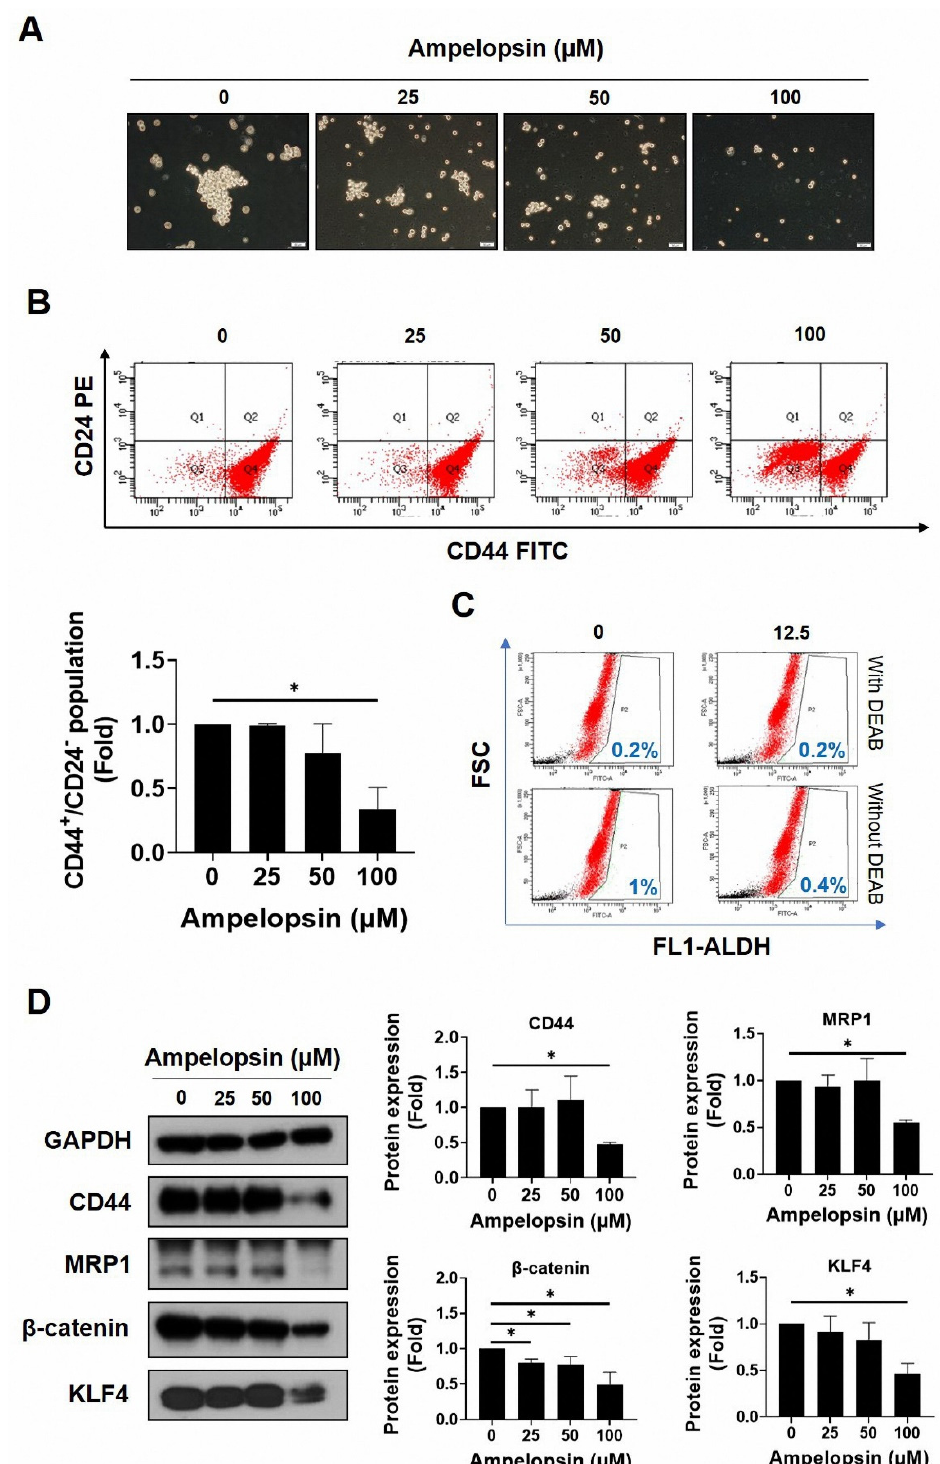
Figure 2. The suppression of ampelopsin on stem-like cell characteristics in MDA-MB-231/IR cells. ( A ) Effect of ampelopsin on mammosphere formation after 10 days of treatment (100 × magnification). ( B ) The CD44 + /CD24 − /low population was measured by FACS after 24 h treatment of ampelopsin. ( C ) ALDH + population after ampelopsin treatment was detected using Aldefluor assay kit and 4-diethylaminobenzaldehyde was considered as a negative control. ( D ) Western blotting analysis of stemness markers after incubation 24 h with ampelopsin. GAPDH was used as the loading control. Original films were shown in Figure S4. * p < 0.05 vs.